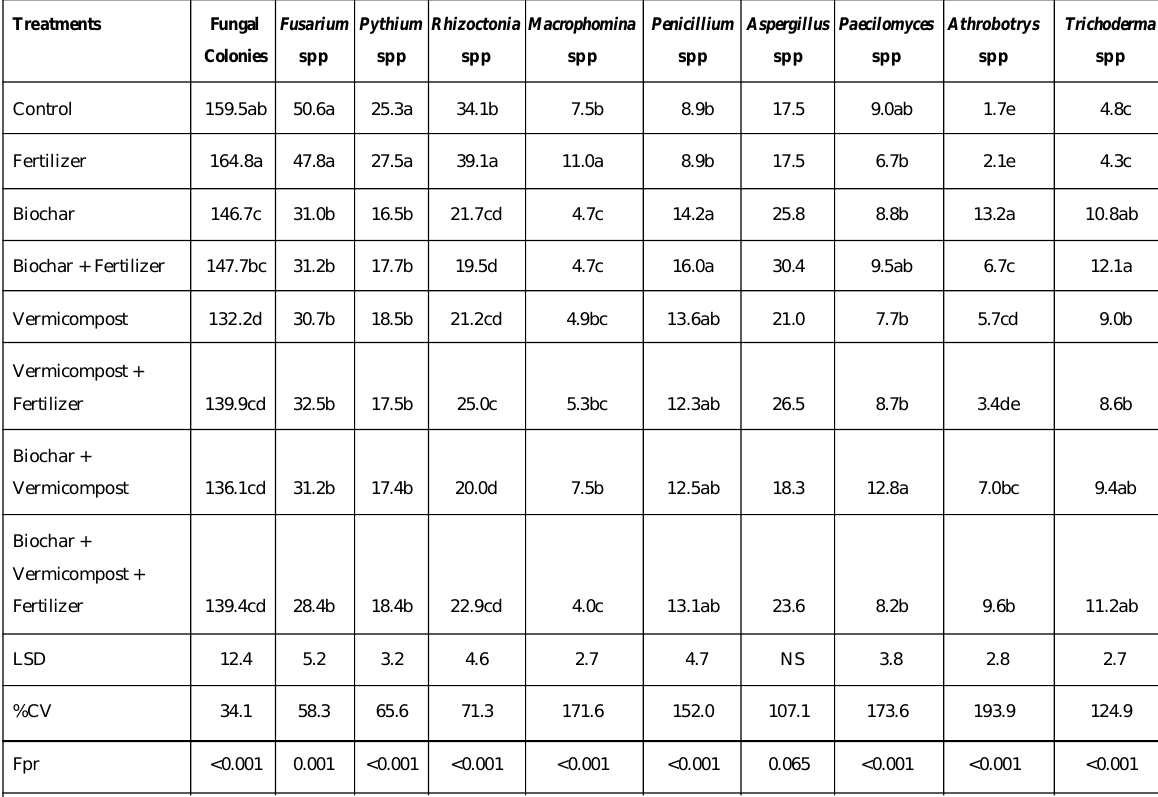
Table 14: Effect of biochar and vermicompost on fungal populations ( × 10 3 CFU/g soil) at harvest of common bean in the long rains season of 2014 Treatments